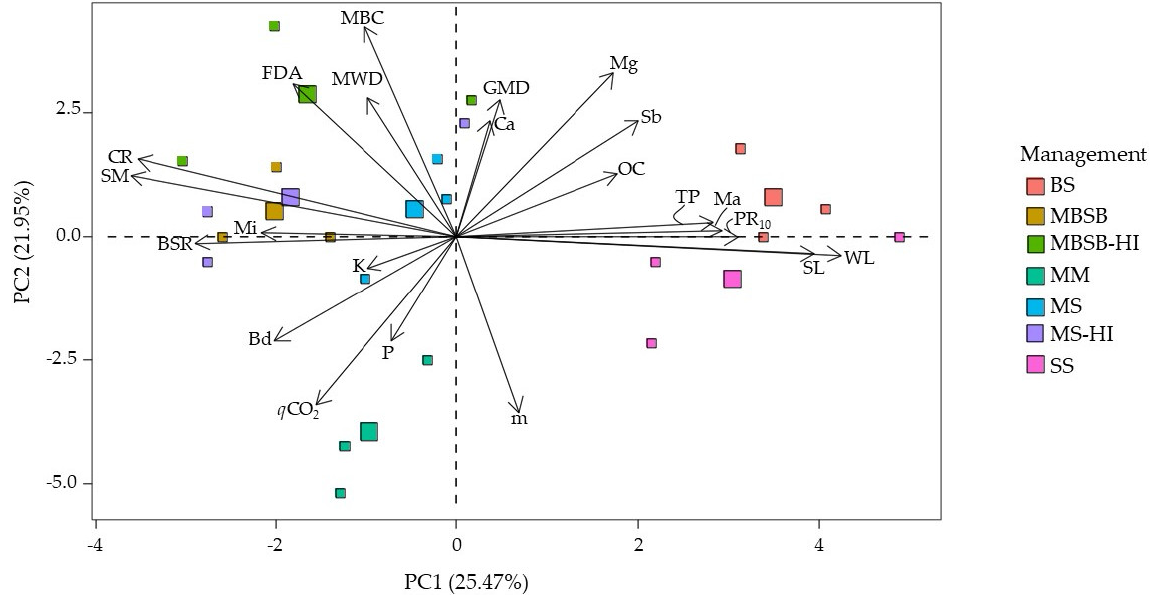
Figure 5. Principal component analysis for variables sampled in the crop rows. SL = soil losses, WL = water losses, CR = cover rate, MBC = microbial biomass carbon, BSR = basal soil respiration, q CO 2 = metabolic quotient, FDA = fluorescein diacetate hydrolysis, OC = soil organic carbon, Sb = sum of bases, m = aluminum saturation of soil, K = potassium, P = phosphorus, Ca = calcium, Mg = magne- sium, MWD = mean weight diameter, GMD = geometric mean diameter, PR 10 = soil resistance to root penetration at 10 cm depth, SM = soil moisture in situ, TP = total porosity, Ma= macroporosity, Mi = microporosity, Bd = bulk density, SS = soybean monoculture, MM = maize monoculture, MS = maize/soybean annual rotation, MBSB = maize/brachiaria/soybean/brachiaria rotation, BS = bare soil, and HI = high input of fertilizers.